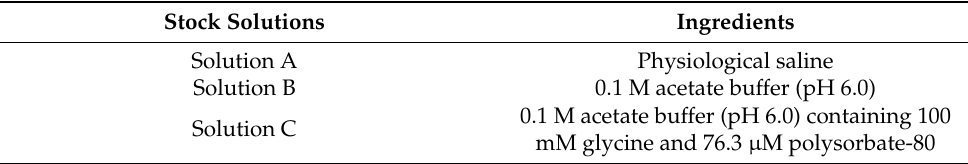
Table 1. Formulation of the stock